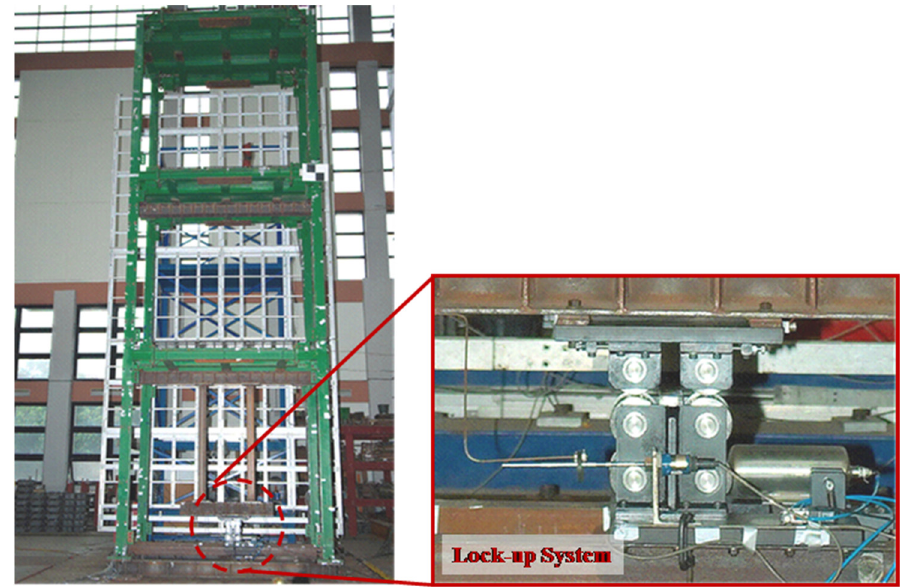
Figure 8. The photograph of the full-scale specimen and the close-up of the lock-up